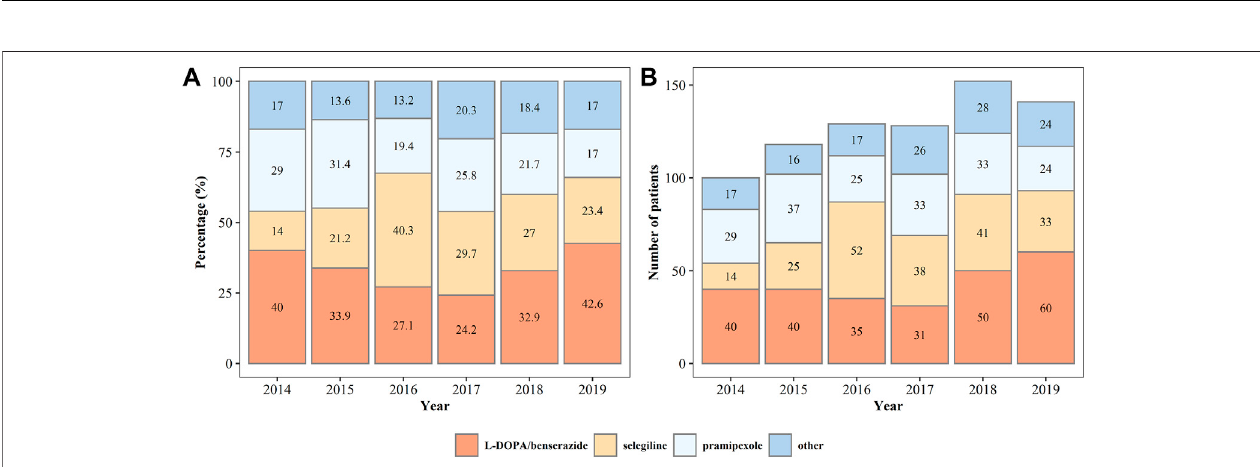
FIGURE 3 | The percentage (A) and number (B) of patients on monotherapy of anti-Parkinson ’ s disease drugs from 2014 to 2019.